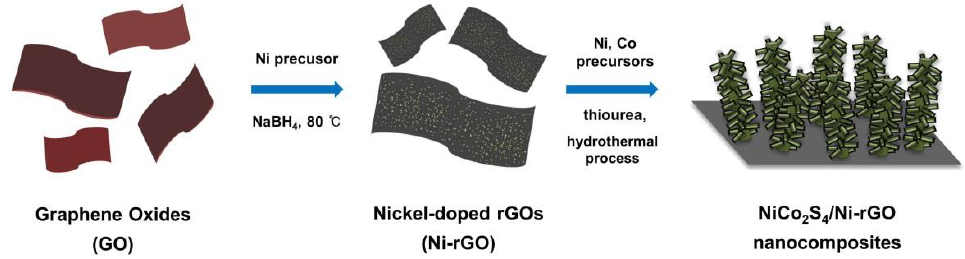
Figure 1. Schematic illustration for the preparation of the NiCo 2 S 4 /Ni-rGO nanotree-like